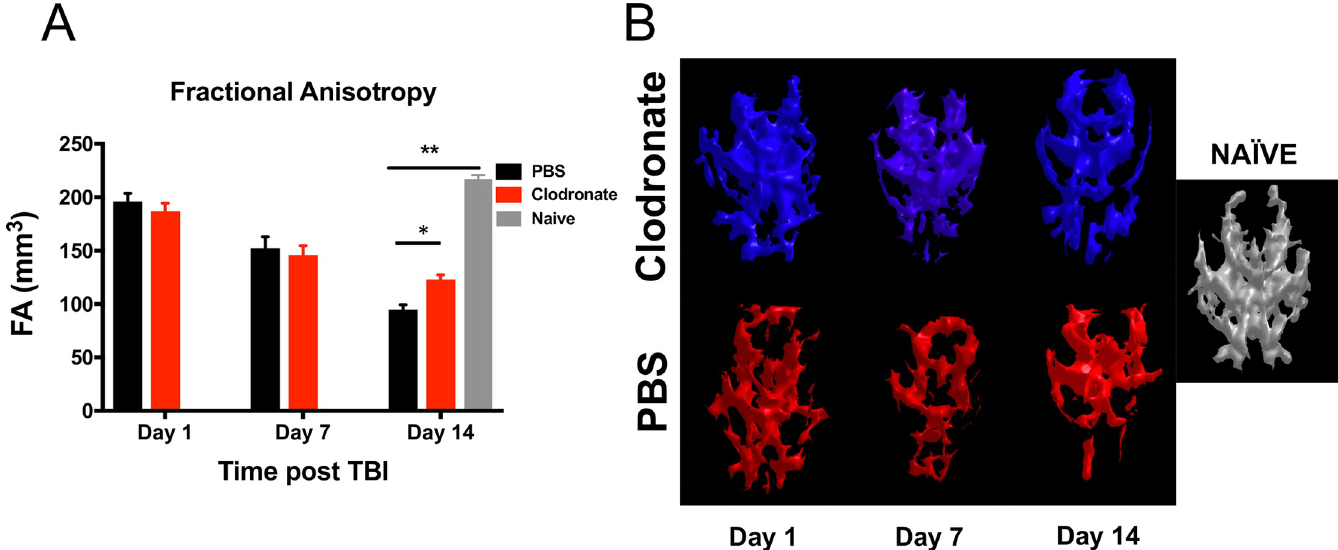
Fig 5. Global fractional anisotropy pattern alterations in monocyte-depleted vs. sham-depleted mice after traumatic brain injury. A) At 14 days post—injury the volume of fractional anisotropy above threshold was significantly higher in monocyte-depleted mice (123.0 ± 4.4mm 3 ) as compared to sham depleted mice (94.9 ± 4.6mm 3 ; � p = 0.025), although both were lower compared to Na ï ve mice (216 ± 3.8mm 3 ; �� p < 0.0001). B) Side by side 3D-rendered representative images of fractional anisotropy patterns in monocyte-depleted vs. sham-depleted mice. Noticeable is the progressive loss of pattern as the injury progresses. The volume of FA and a representative 3D-rendered FA pattern from a na ï ve mouse is provided for comparison.